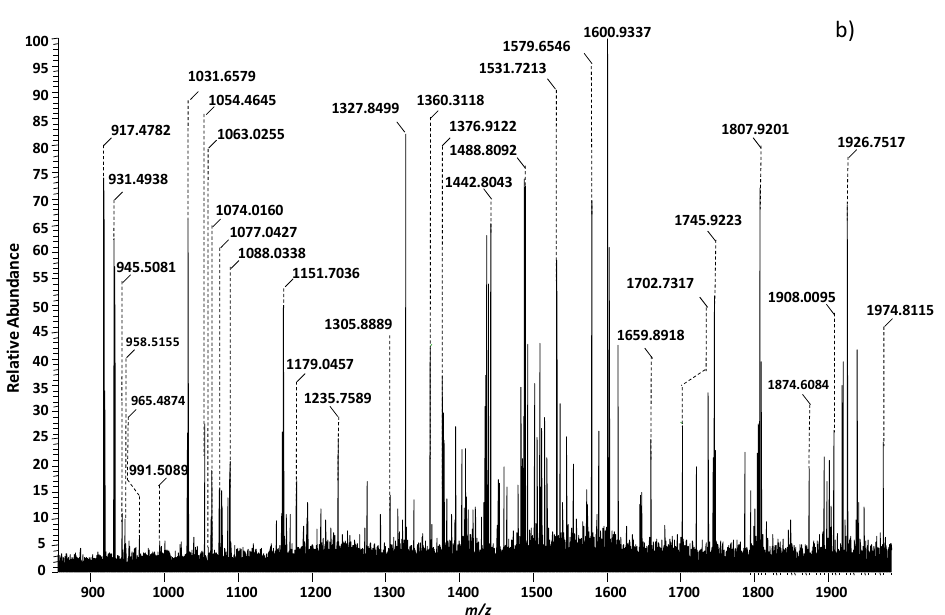
Figure 4. (-)NanoESI Orbitrap MS of HE42 mixture. ( a ) m / z range (600–900); ( b ) m / z range (900–2000). Figure 4. ( ‐ )NanoESI Orbitrap MS of HE42 mixture. ( a ) m / z range (600 ‐ 900); ( b ) m / z range (900–2000). Solvent: methanol; sample concentration: 5 pmol/ µ L; acquisition time: 2 min; spray voltage: 0.65 kV Solvent: methanol; sample concentration: 5 pmol/ μ L; acquisition time: 2 min; spray voltage: 0.65 kV (reprinted with permission from [171]). (reprinted with permission from [171]).